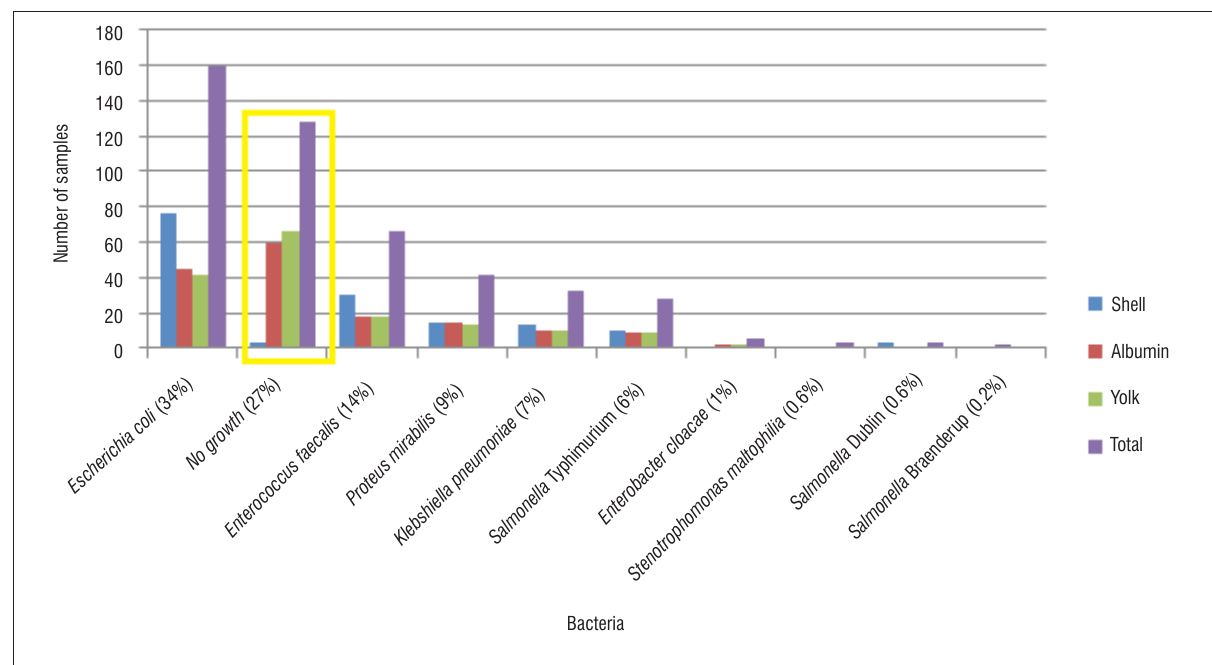
Figure 1: Distribution of different presumptive bacterial species isolated from the shell, albumin and yolk of retailed hens’ eggs ( n =468).